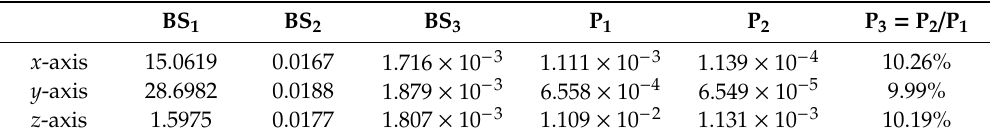
Table 4. Bias stabilities of the experimental data in 2nd